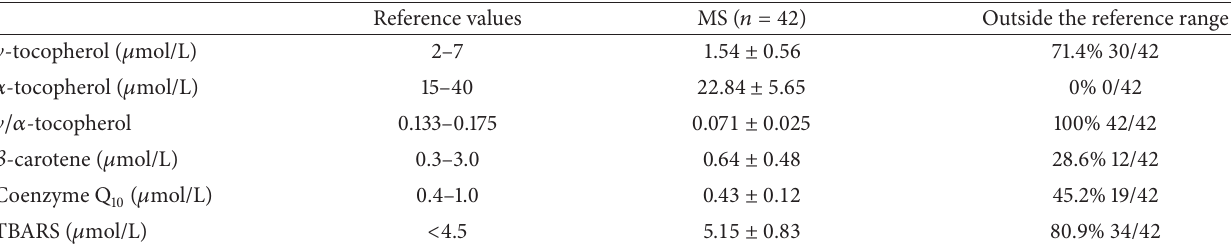
Table 3: Serum levels of some lipophilic antioxidants and TBARS (thiobarbituric acid reactive substances) in patients with multiple sclerosis (MS) compared with reference